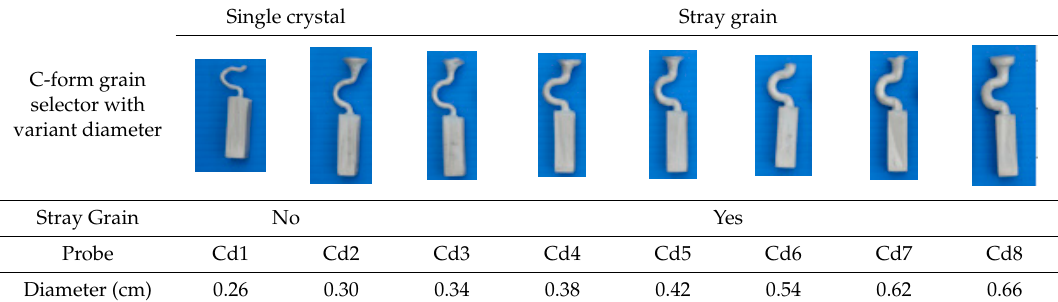
Table 1. Different thickness parameters of the C-form grain selectors: Group 1.